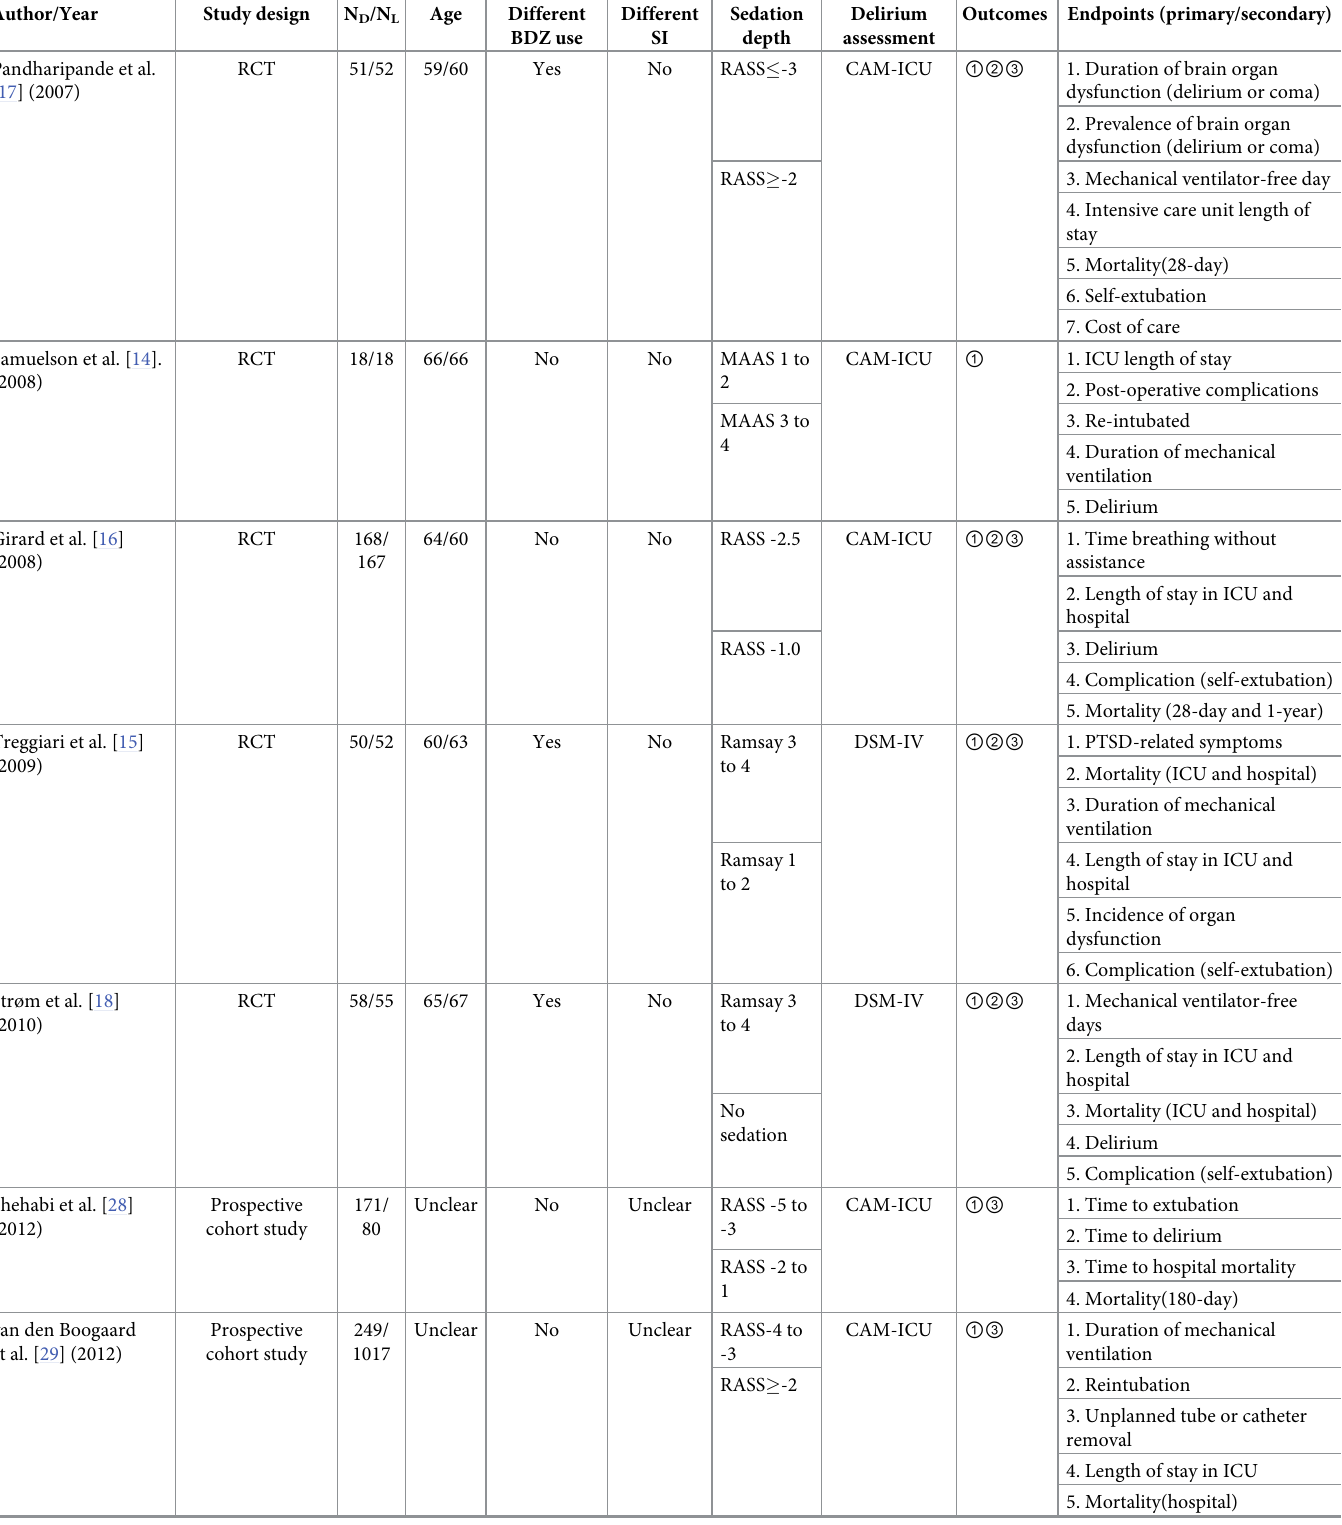
Table 1. Characteristics of the included